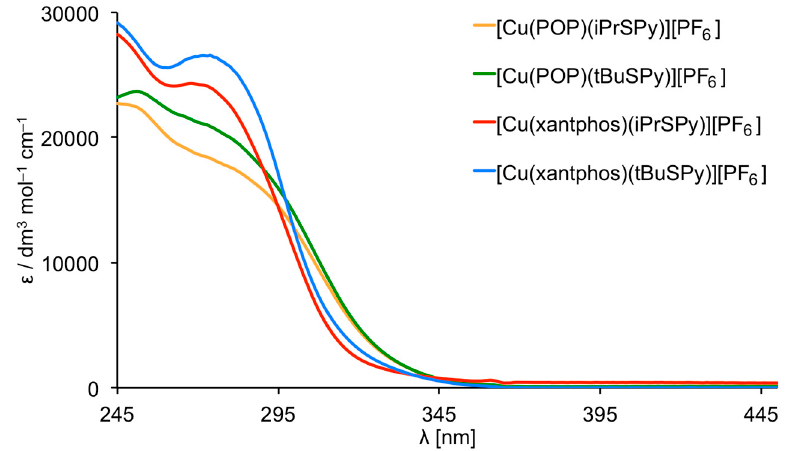
Figure 9. Absorption spectra of CH 2 Cl 2 solutions of [Cu(P^P)(N^S)][PF 6 ] complexes (concentration = 2.5 × 10 − 5 mol dm − 3 ). Table 2. Solution (CH 2 Cl 2 , 2.5 × 10 − 5 mol dm − 3 ) absorption maxima and solid-state emission data for